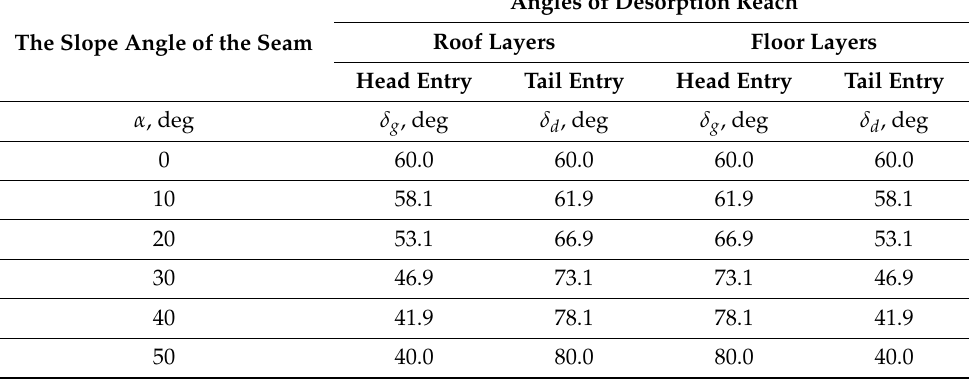
Table 2. The values of desorption